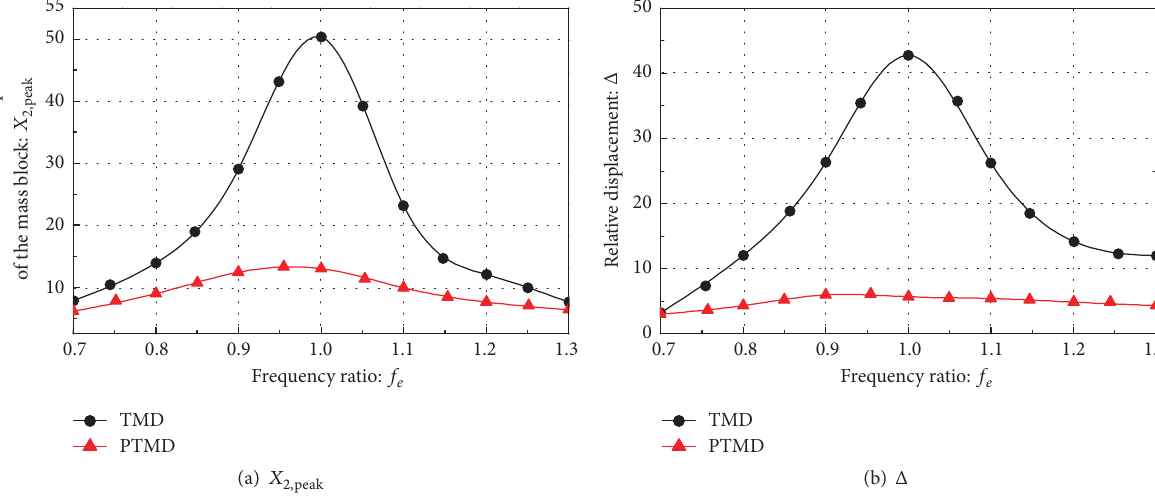
, 𝛿 = 2 , and 𝜇 = 2 %; TMD: 𝜉 2 = 3𝜉 opt